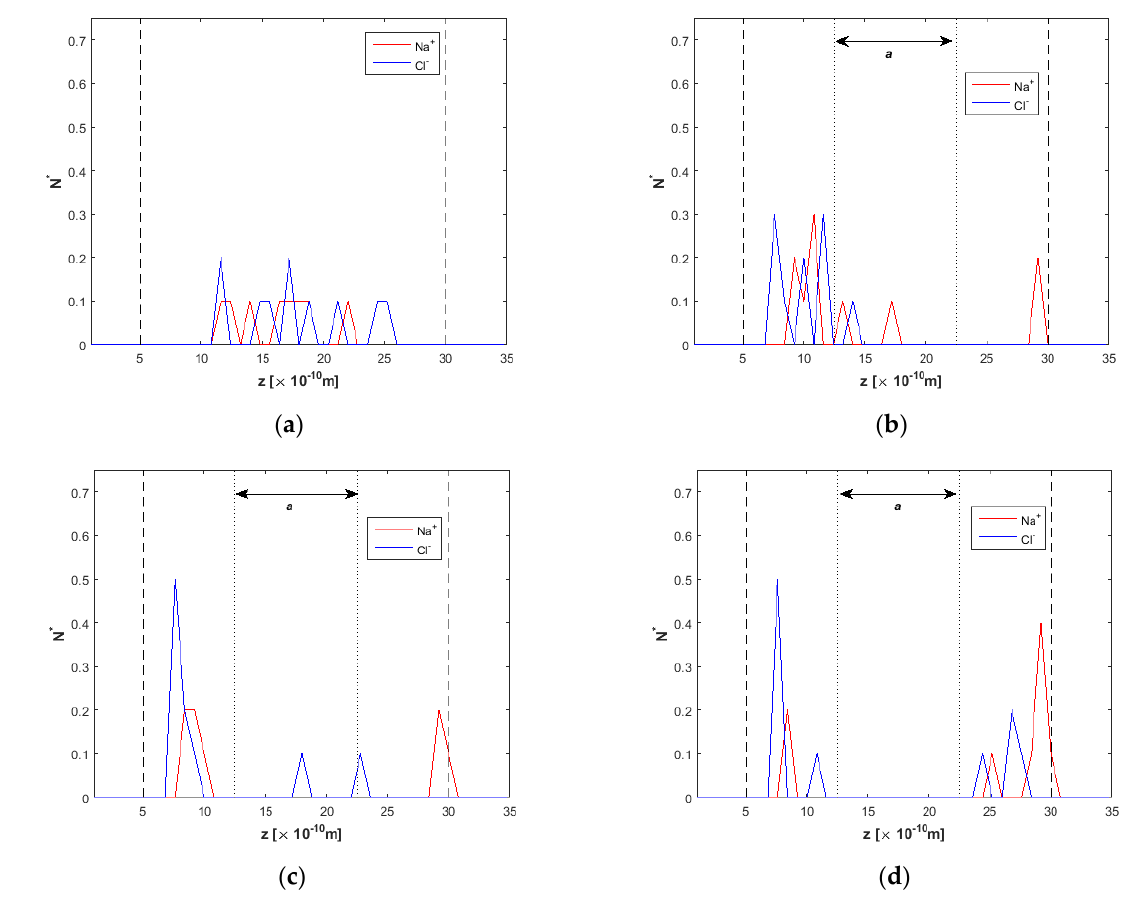
Figure 9. Ion concentration across the h = 2.5 nm nanochannel at various times of the simulation, F ext